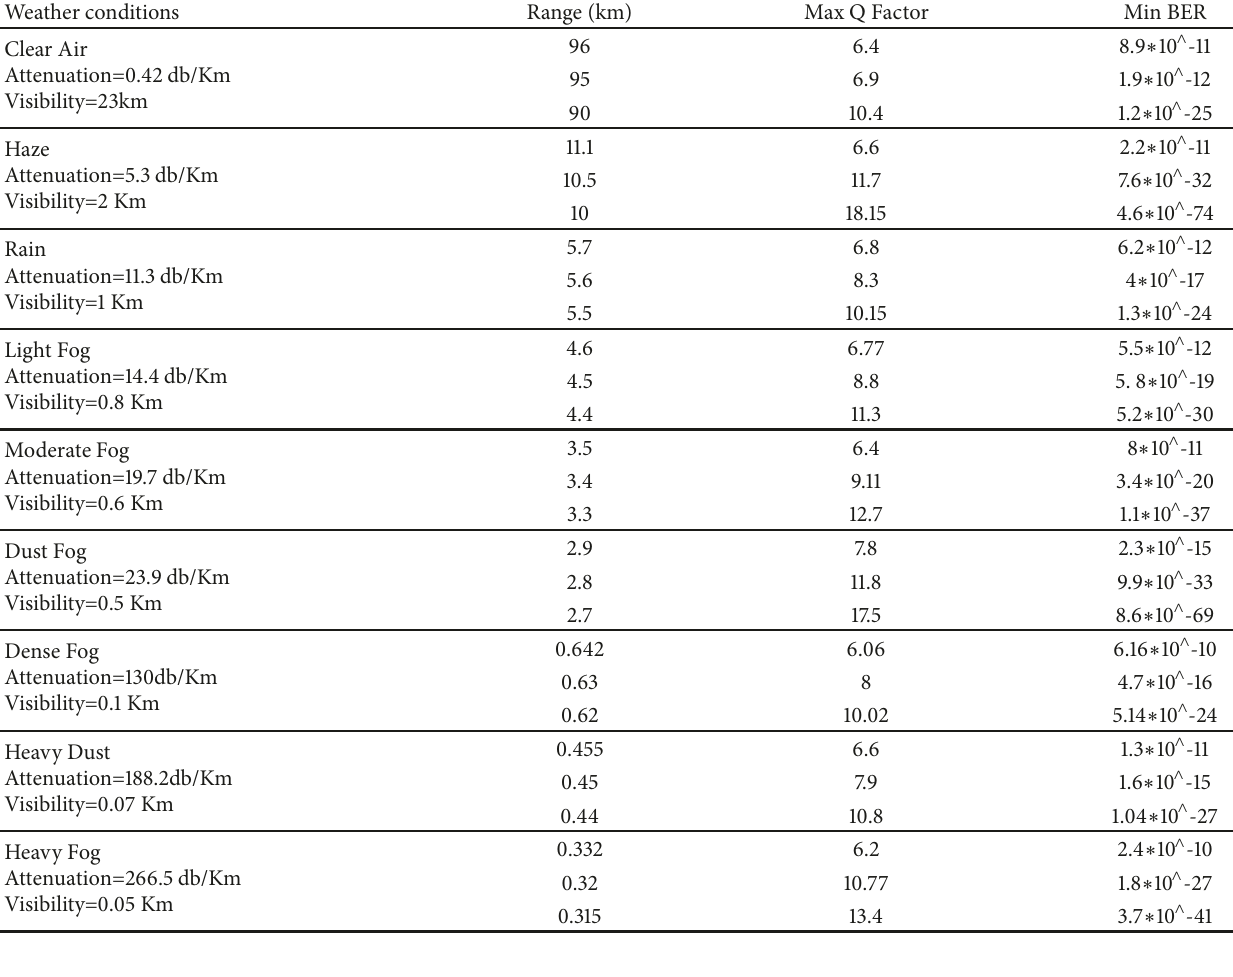
Table 8: Results for 4T X /4R X FSO at different weather conditions for 𝜆 = 850 nm.